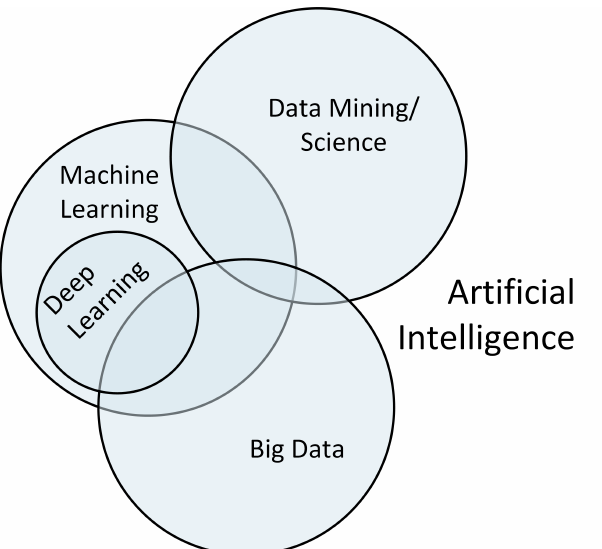
Figure 1. Illustration of the interrelation of different intelligent computational techniques